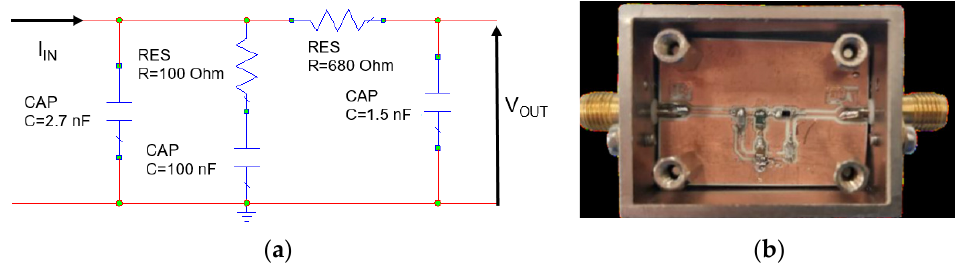
Figure 7. Schematic of the PLL loop ( a ) and its realization with SMD technology ( b ). To start up the radar, the registers of the ADF4159 PLL board are initialized by using the Analog Devices ADF4158-9 PLL software. With this tool, the radar chirp, identified with ADSimPLL software, was synthetized by means of 128 frequency steps, with a deviation of 122 kHz and a time duration of 8.12 µ s. In this way, the time chirp duration is 1039 µ s, and the total ramp frequency shift is 15.625